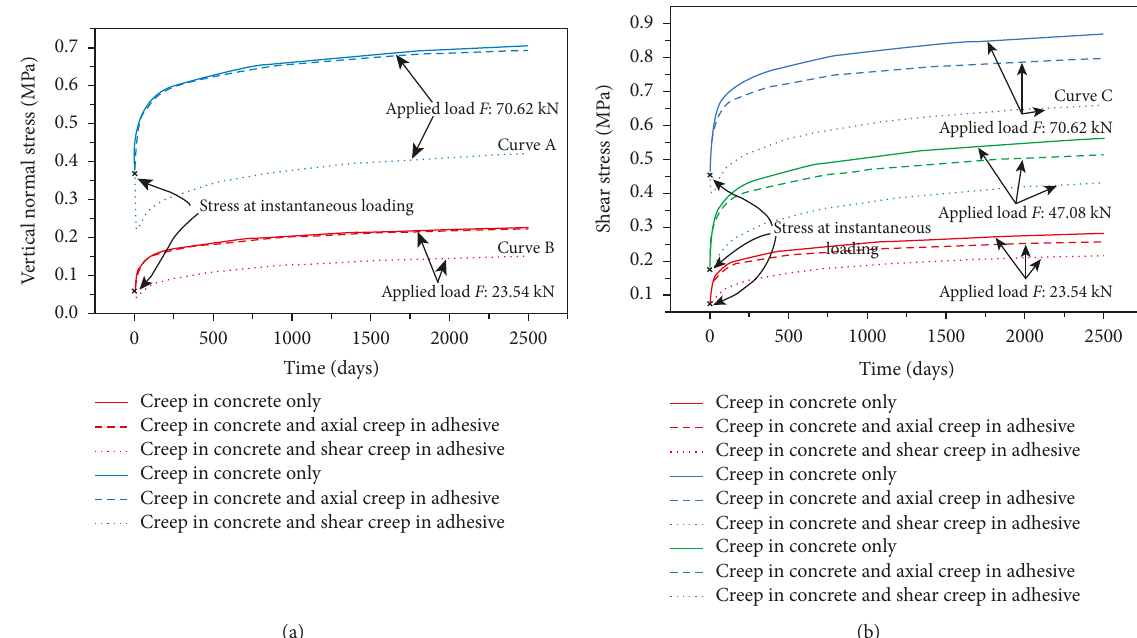
Figure 15: The combined effect of adhesive creep and concrete creep on the edge stresses. (a) Variation of vertical normal stress with time. (b) Variation of shear stress with